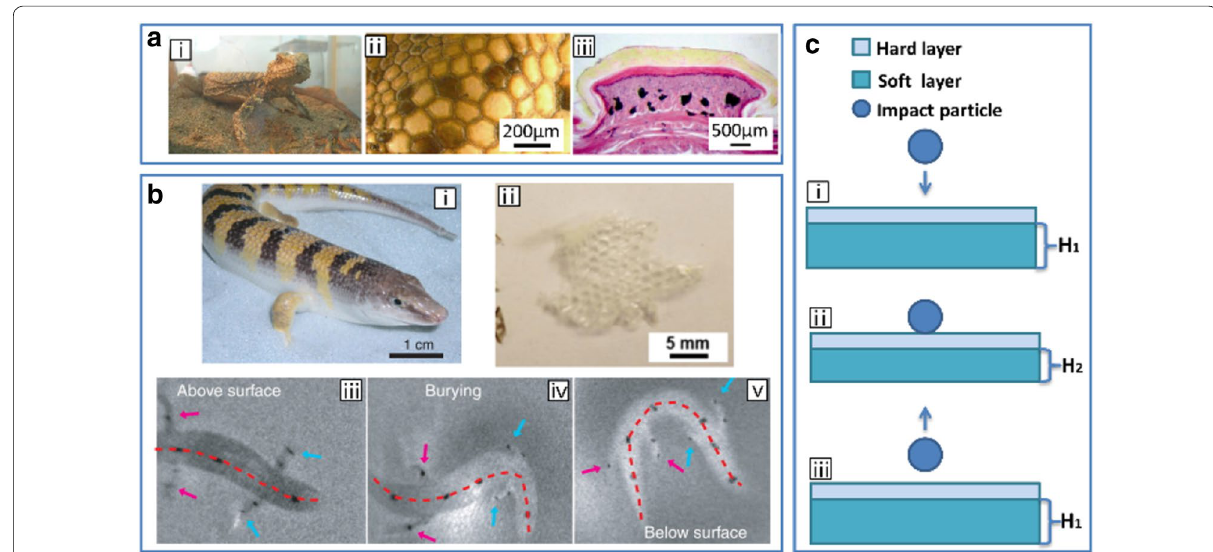
Figure 8 ( a ) The buffered structure of a desert lizard ( Laudakin stoliczkana ): (i) desert lizard (Provided by He Huang), (ii) a microscopic image of the scales of desert lizard [24], (iii) a section image of a single scale of desert lizard [24]; ( b ) Scales and dynamics of the sandfish ( Scincus scincus ): (i) sandfish [25], (ii) scales of the sandfish [26], (iii) X-ray image of the sandfish when moving on the surface [25], (iv) X-ray image of the sandfish when moving subsurface but its limbs are not buried in sand [25], (v) X-ray image of the sandfish when moving subsurface and all its body is buried in sand [25]; ( c ) A schematic diagram of the buffered structure: (i) an impact particle does not contact with the surface of the multilayer material, (ii) an impact particle collides with the multilayer material, (iii) an impact particle leaves the surface of the multilayer material, H is the thickness of the soft layer, and H 1 is greater than H